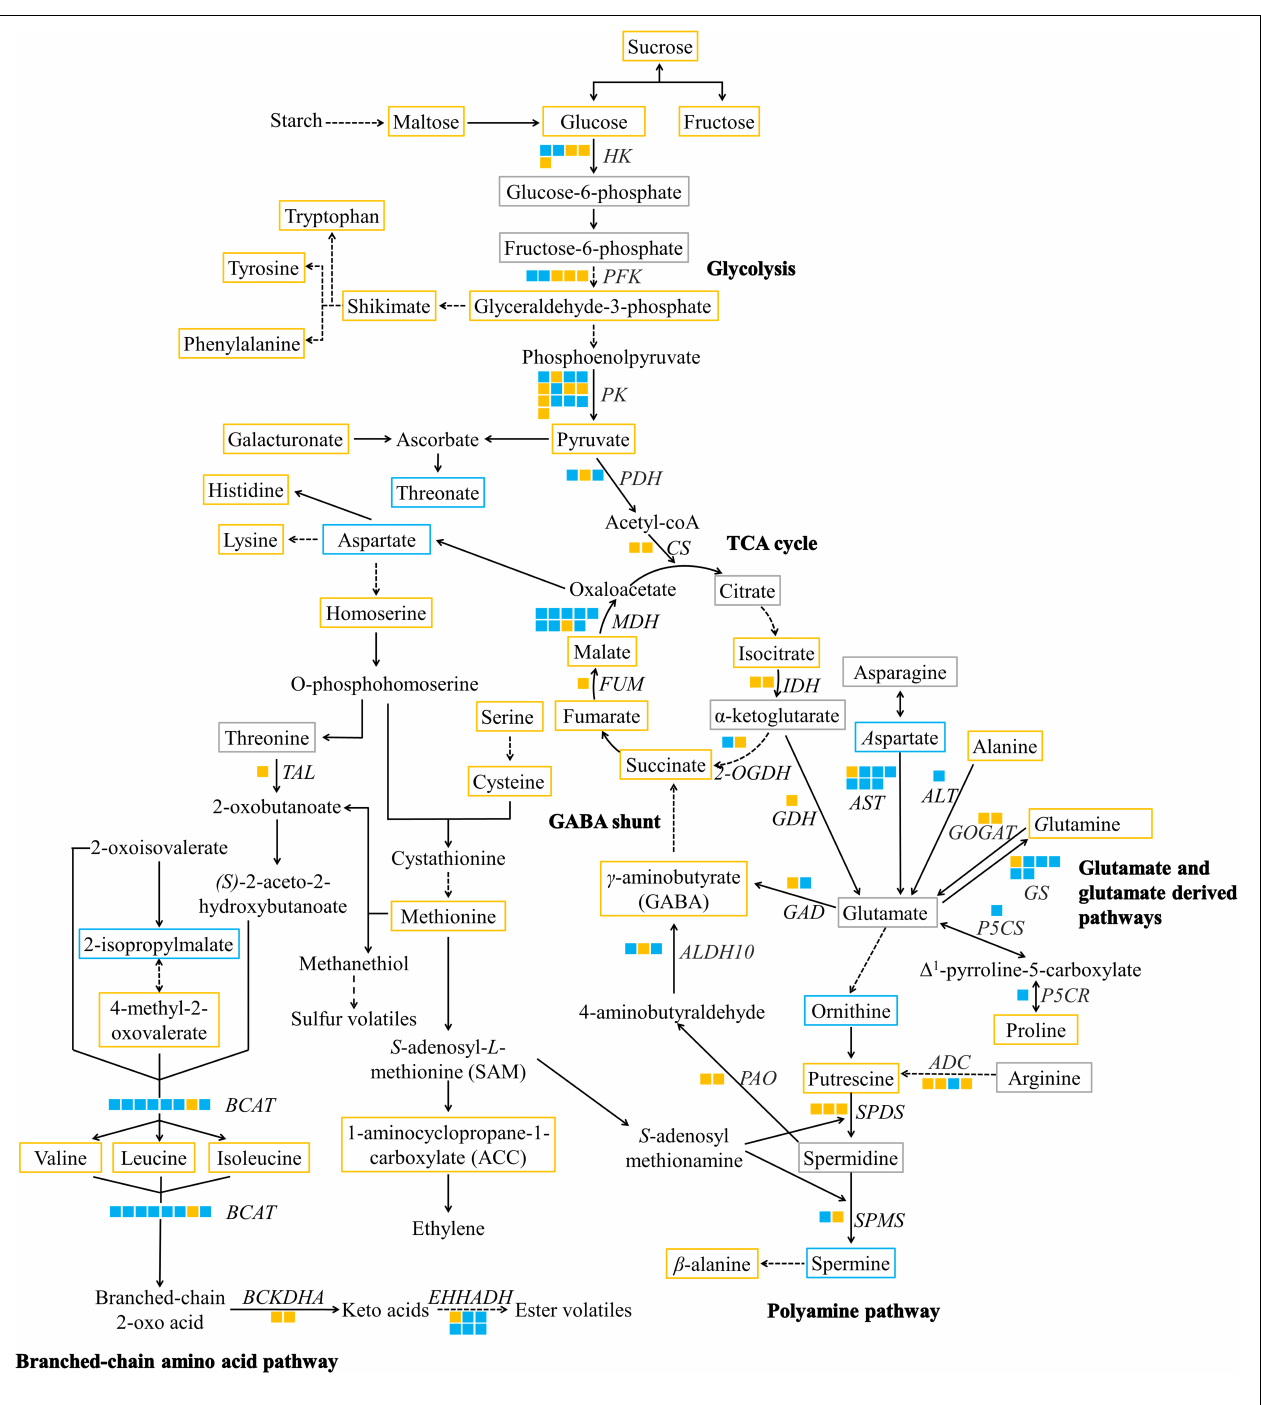
FIGURE 5 | A metabolic map of significantly altered metabolites and DEGs of taste-associated pathways during durian cv. Monthong ripening. Metabolites with significantly increased, significantly decreased, and unchanged contents are outlined in orange, blue, and gray, respectively. Undetectable metabolites are shown without boxes. Isoforms of each putative gene are represented by a solid box, and each isoform is arranged by locus number. Upregulated and downregulated isoforms are colored in orange and blue, respectively. Solid arrows indicate one enzymatic reaction, while dash arrows indicate multiple reactions. HK, hexokinase; PFK , phosphofructokinase; PK, pyruvate kinase ; PDH , pyruvate dehydrogenase; CS , citrate synthase; IDH , isocitrate dehydrogenase; 2-OGDH , α -ketoglutarate dehydrogenase; FUM , fumarase; MDH , malate dehydrogenase; AST , aspartate aminotransferase; ALT , alanine aminotransferase; GDH , glutamate dehydrogenase; GOGAT , glutamate synthase; GS , glutamine synthetase; P5CS, (cid:49) 1 -pyrroline-5-carboxylate synthetase ; P5CR , (cid:49) 1 -pyrroline-5-carboxylate reductase; ADC , arginine decarboxylase; SPDS , spermidine synthase; SPMS , spermine synthase; GAD , glutamate decarboxylase; PAO, polyamine oxidase; ALDH10 , 4-aminobutanal dehydrogenase; TAL , threonine ammonia-lyase; BCAT, branched-chain amino acid transaminase ; BCKDHA , 3-methyl-2-oxobutanoate dehydrogenase; EHHADH , long-chain-enoyl-CoA hydratase.